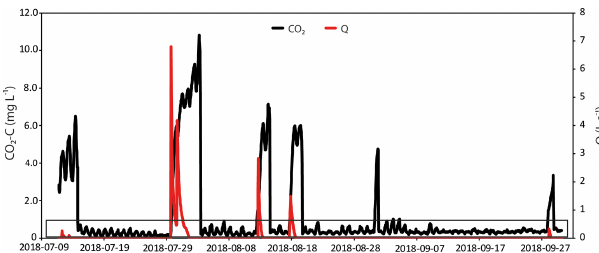
Figure 9. Stream CO 2 concentration (black) and discharge (red) for the dry period (July–September 2018). Periods when the CO 2 sen- sor was above the water table capturing an atmospheric signal (i.e. with concentrations < 0 . 5mgCL − 1 ) are highlighted by the lower